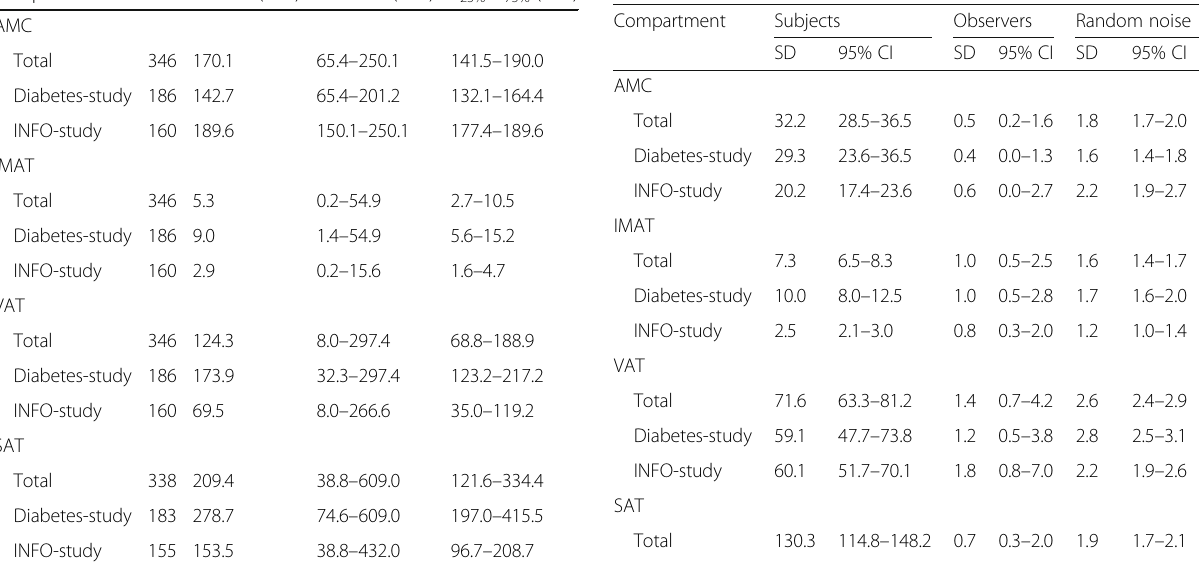
Table 1 Descriptive statistics of segmentation data per study Compartment